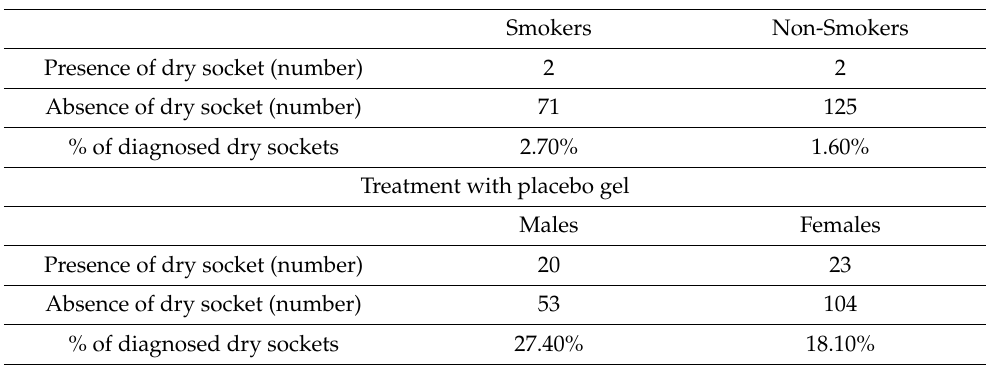
Table 5. The table displays the number of diagnosed dry sockets in smoker and non-smoker patients after treatment with ozone in the form of sunflower-oil-based gel (Ozosan) or placebo gel. The incidence percentage of dry sockets was calculated with respect to the number of female patients (113) or male patients (87) with third molars extracted. The * symbol denotes a statistically significant difference between the two treatments, as calculated using the chi-square